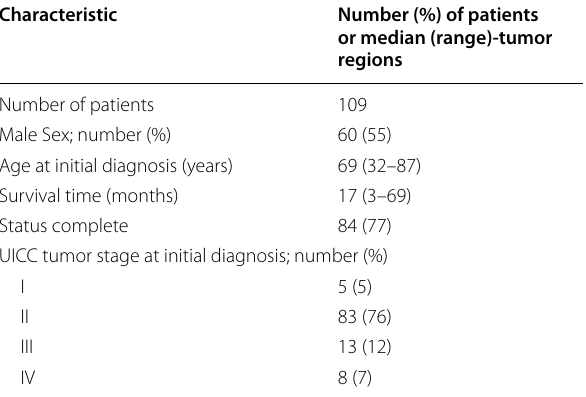
Table 1 Clinical characteristics of the PDAC